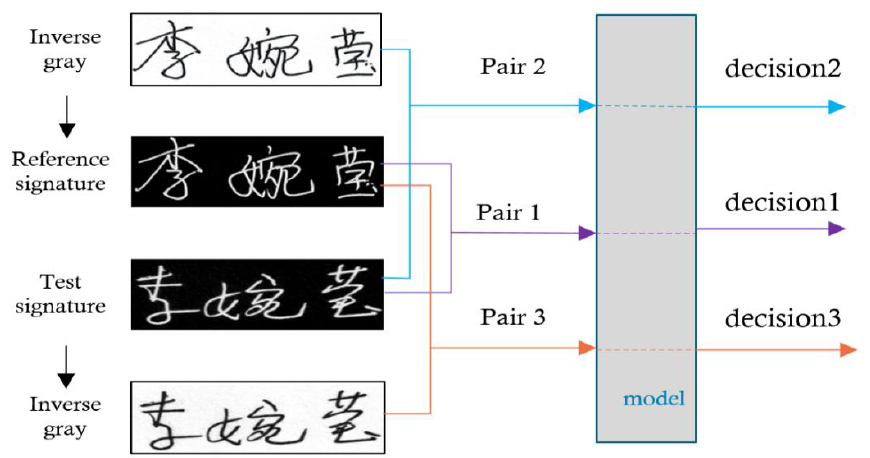
Figure 3. IDN network framework. (Example of Chinese signature in the figure: Li wanying )